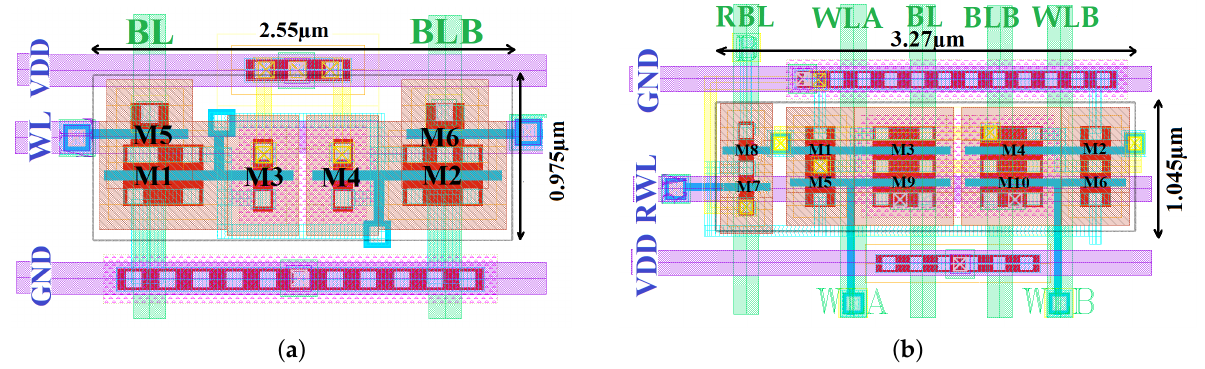
Figure 14. Layout of ( a ) 6T SRAM cell and ( b ) the proposed D 2 LP10T SRAM